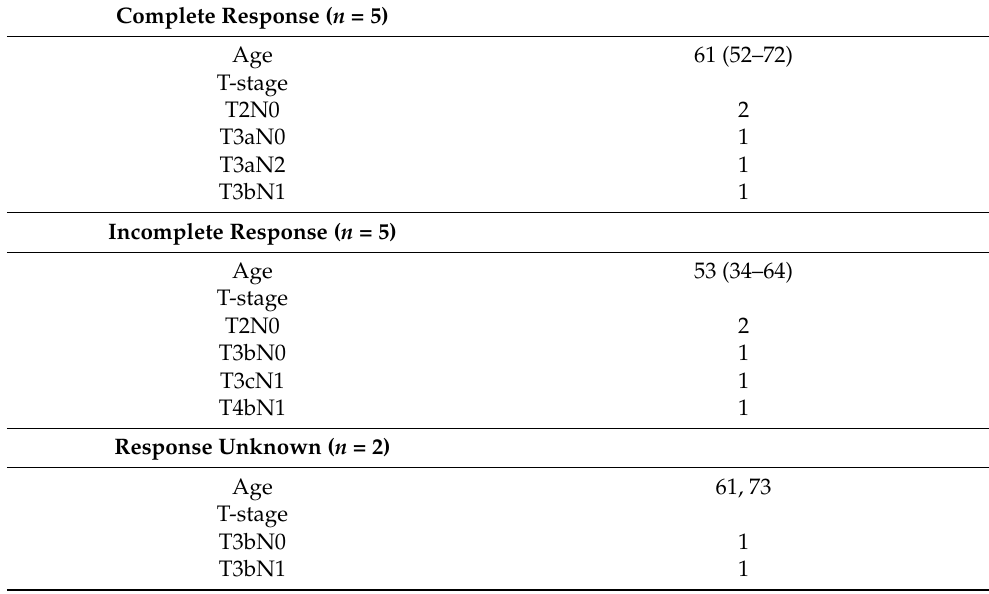
Table 1. Patient age and T-stage, sorted by response status. Age is presented as median